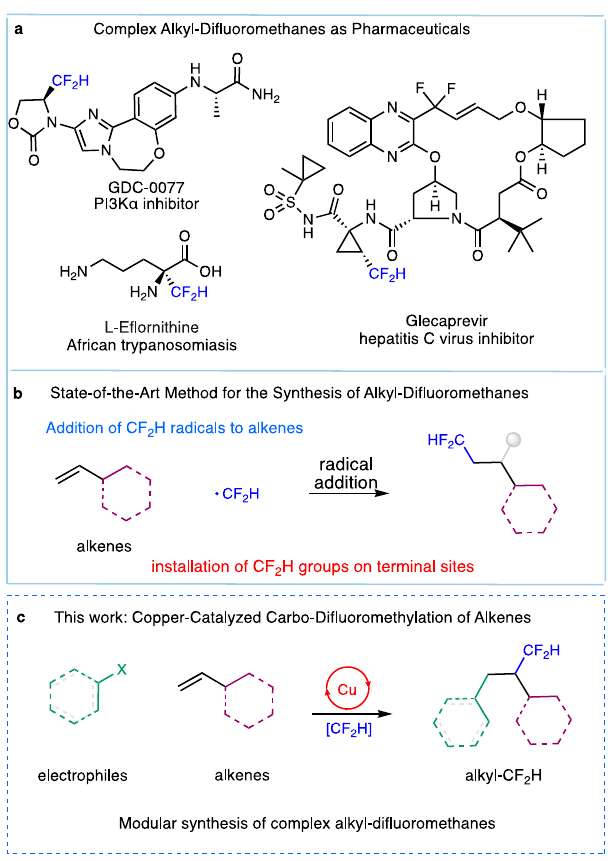
Fig. 1 Copper-catalyzed carbo-di fl uoromethylation of alkenes could enable modular synthesis of complex alkyl-di fl uoromethanes. a Complex alkyl-di fl uoromethanes as pharmaceuticals. b A state-of-the-art method for the synthesis of alkyl-di fl uoromethanes. c Copper-catalyzed carbo- di fl uoromethylaton of alkenes.